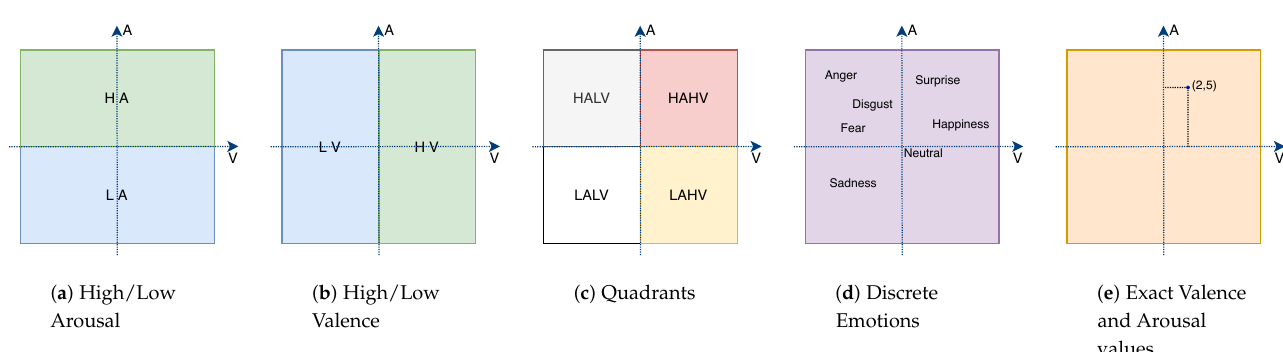
Figure 1. The typical set of emotions recognized in the literature ( a – d ) and what we want to achieve with our work ( e ). A: arousal; V: valence. (best seen in